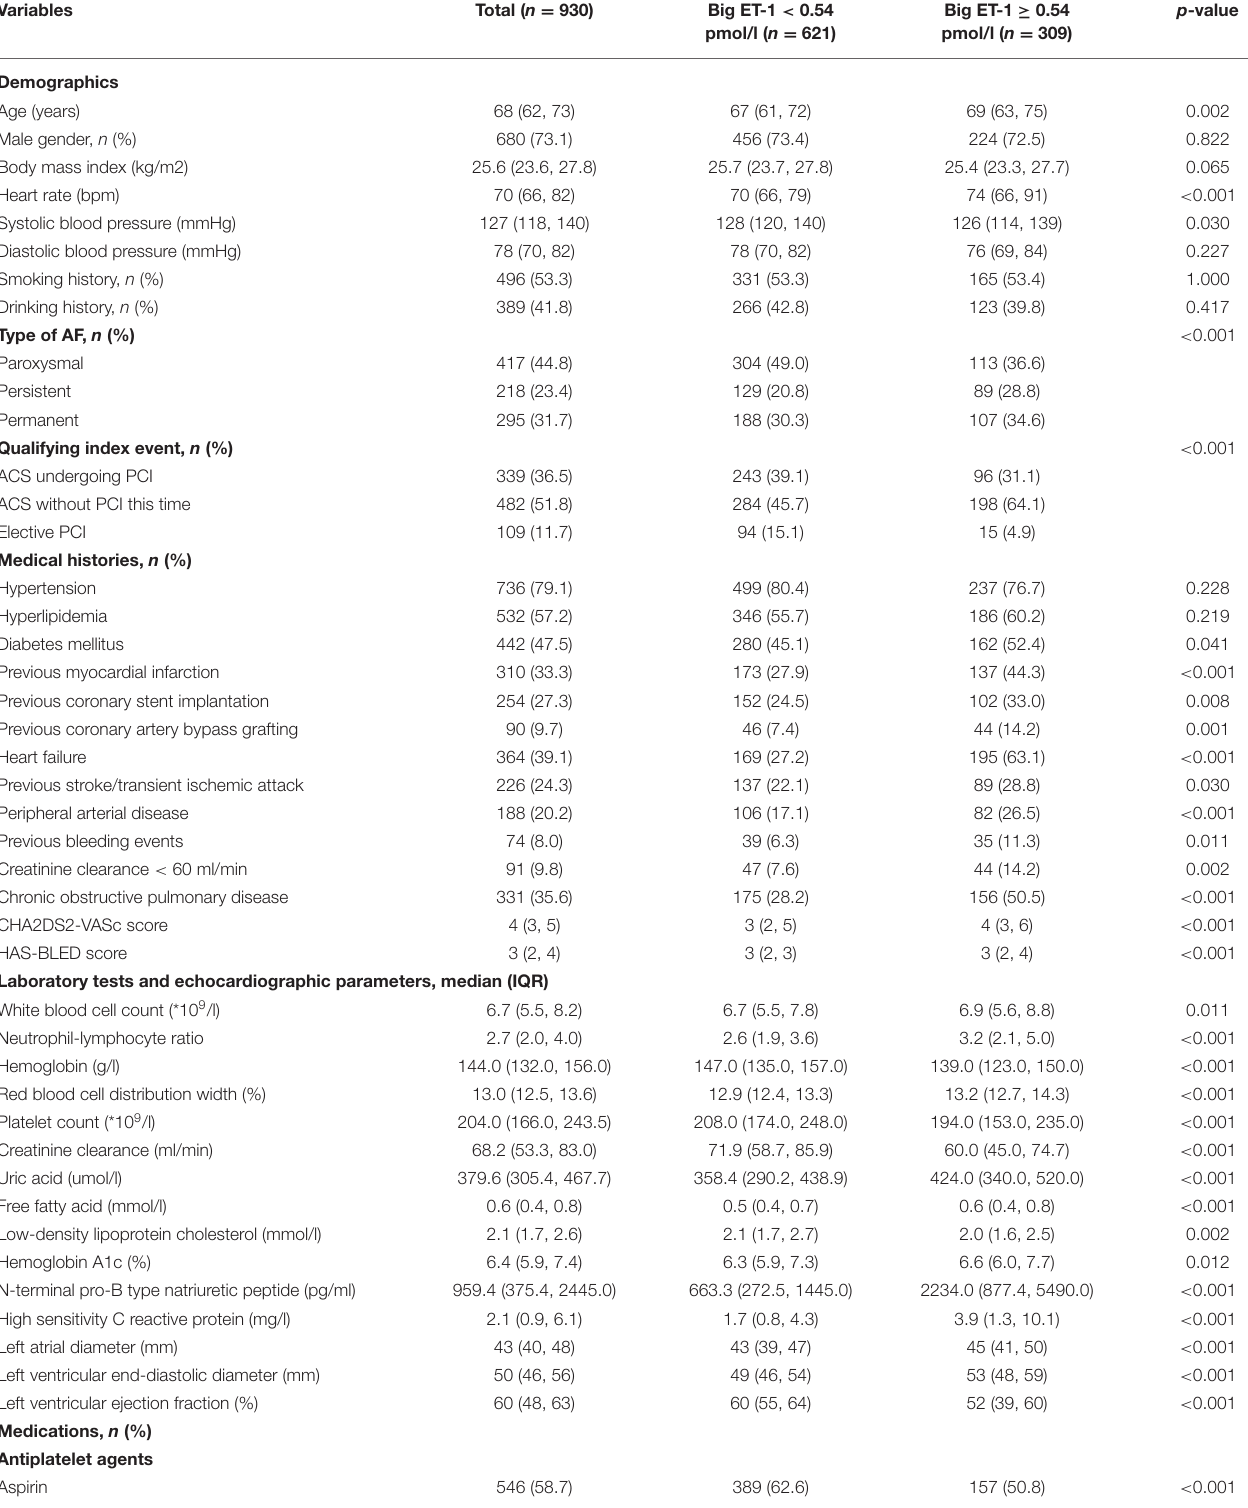
TABLE 1 | Baseline characteristics of patients with AF and ACS or undergoing